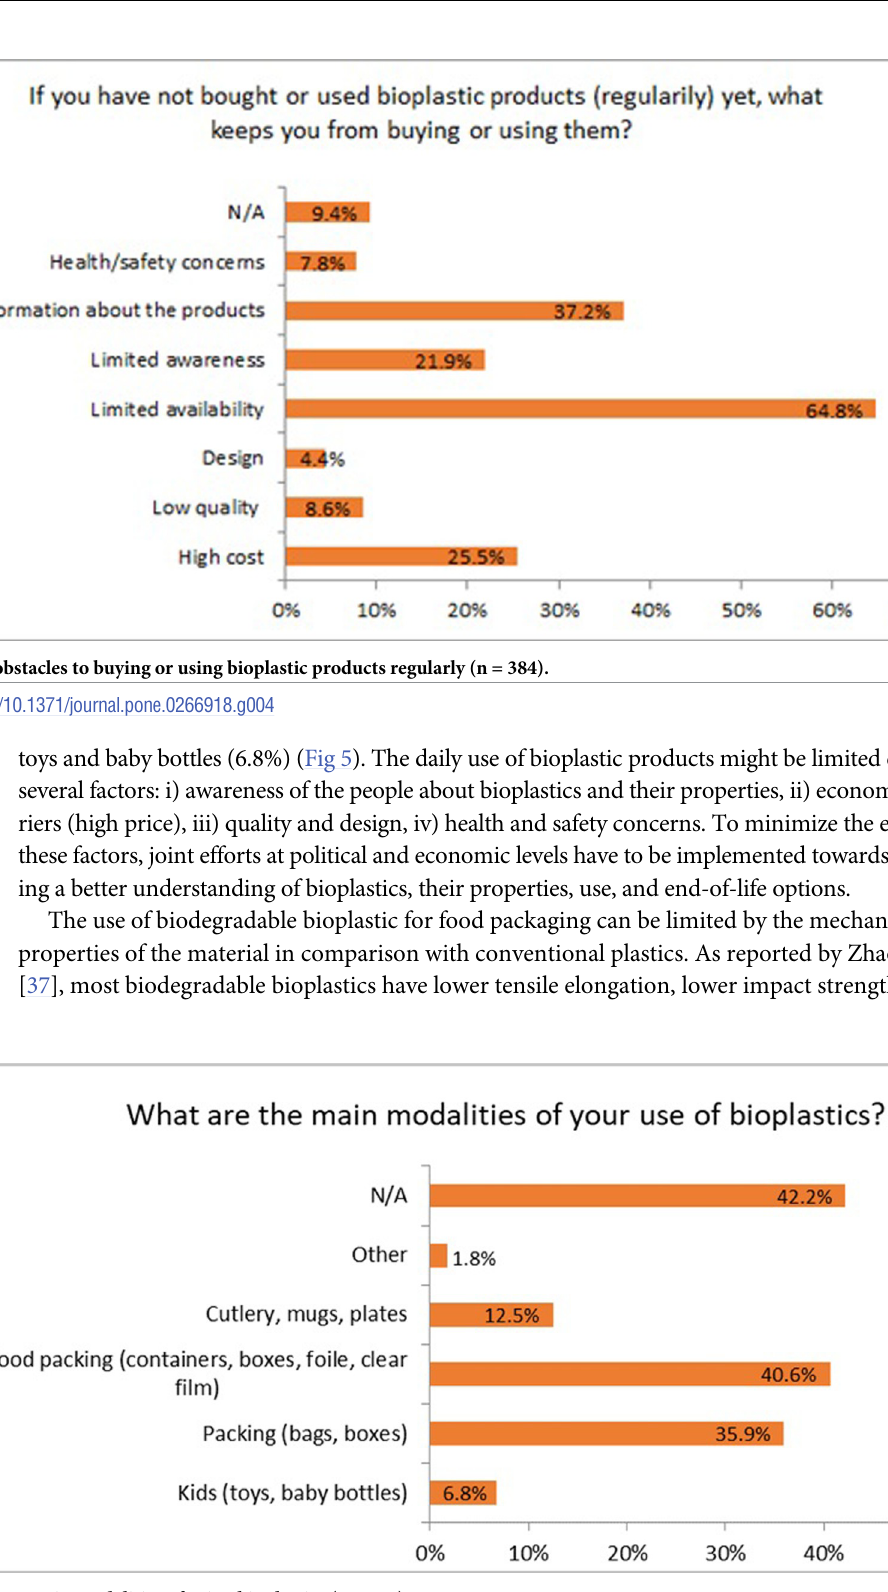
Fig 5. Main modalities of using bioplastics (n =